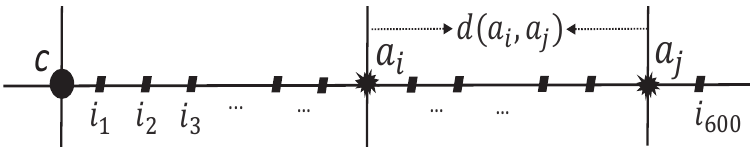
Figure 5. An example of deleting an